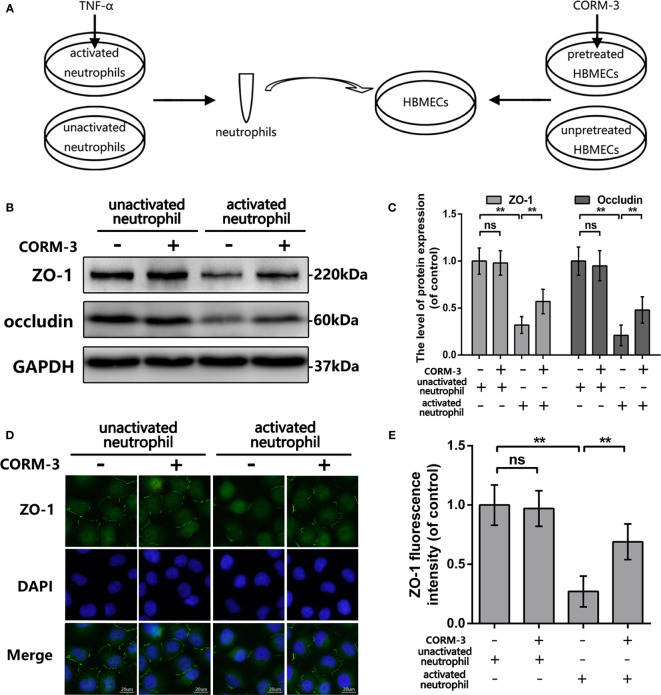
CORM-3 alleviated TJ protein degradation induced by activated neutrophils in HMBECs, in vitro. (A) Schematic experimental settings for the neutrophils and HBMECs co-culture. (B, C) The protein expression of ZO-1 and Occludin in HBMECs treat as above. (D, E) Representative immunofluorescence staining and quantification data of ZO-1 in HBMEC. (bar: 20 μm). All data is denoted as mean ± S.D. (n = 5). **P < 0.01. NS, No significant.